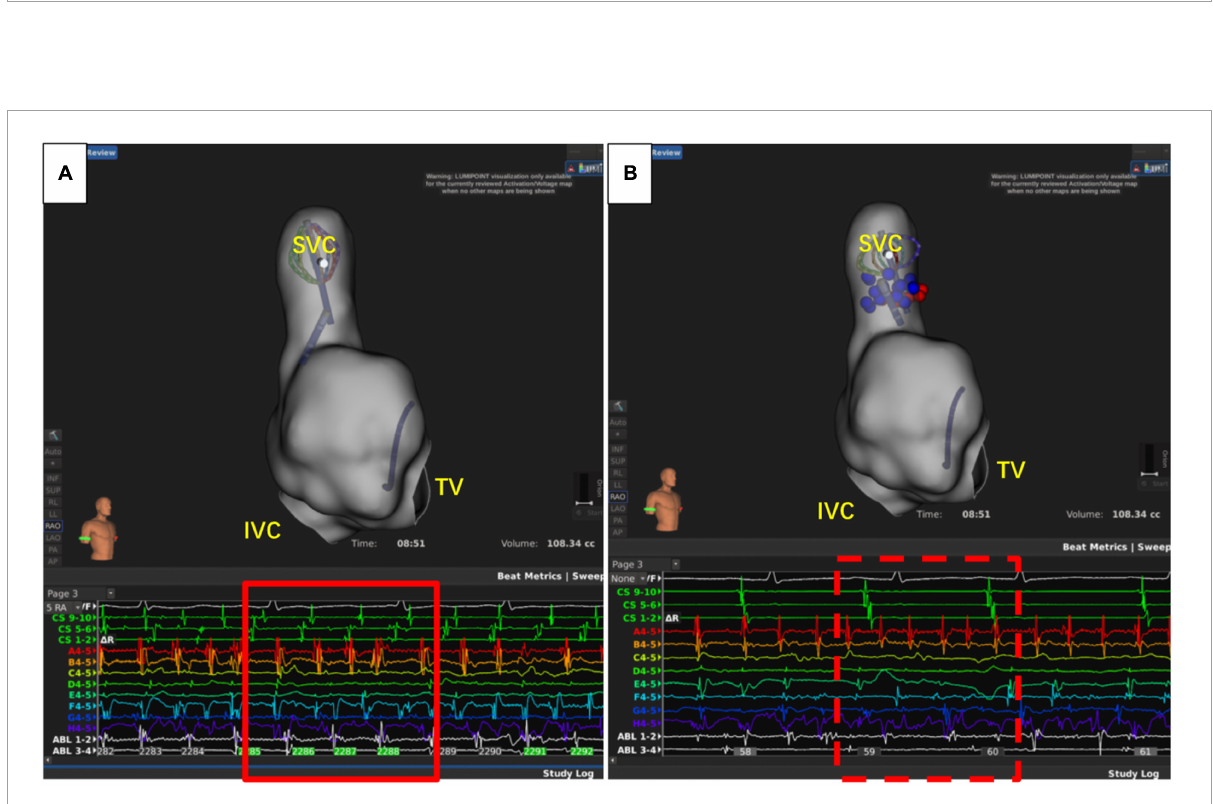
FIGURE5 Superior vena cava (SVC) triggers atrial fibrillation. (A) Atrial fibrillation before isolation of SVC. (B) After SVC isolation, sinus rhythm was restored in the atrium, while the atrial fibrillation rhythm was sustained in SVC. IVC, inferior vena cava; TV, tricuspid